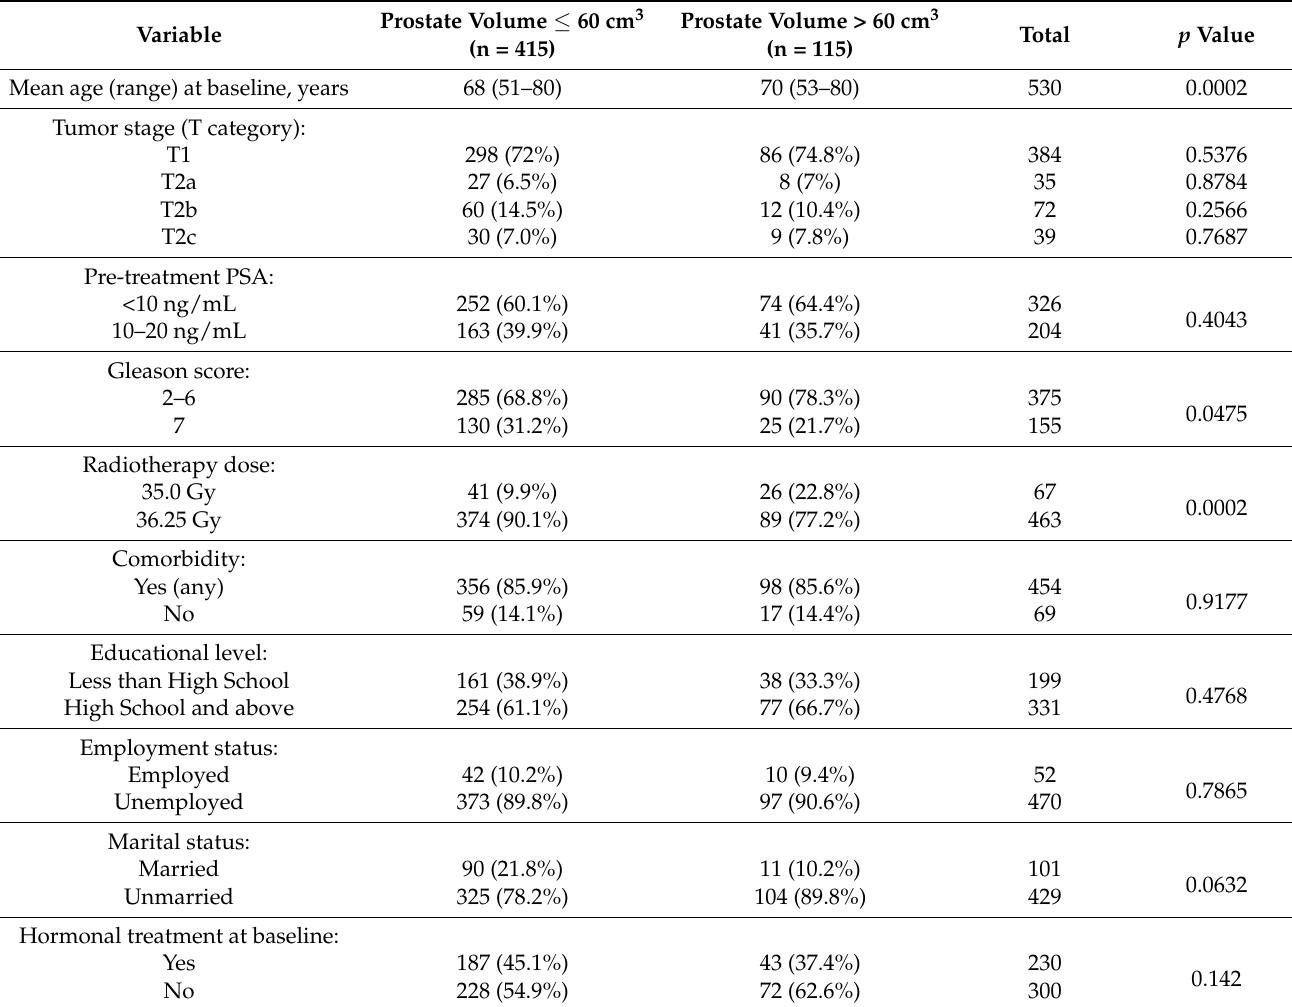
Table 1. Demographic, clinical, and treatment characteristics of the study population by prostate